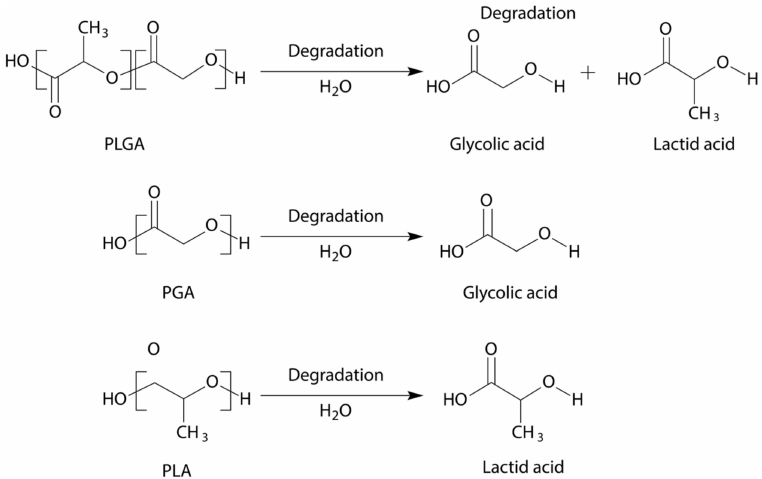
Figure 10. Degradation of PLGA ( top ), PGA ( middle ), PLA ( bottom ). PLA is an eco-friendly, hydrophobic, thermoplastic, high-strength, high-modulus material approved by the FDA for direct contact with biological fluids that degrades slower than PGA and can be produced from renewable biomass resources (e.g., corn, potato, beet). PLA degradation products are not toxic in the human body; it is hydrolyzed to its constituent α -hydroxy acid, which does not interfere with tissue healing and can be eliminated in a natural way. PLA degradation depends on its molar mass, conformation, and copolymer composition; compared to its copolymer, pure PLA shows a longer